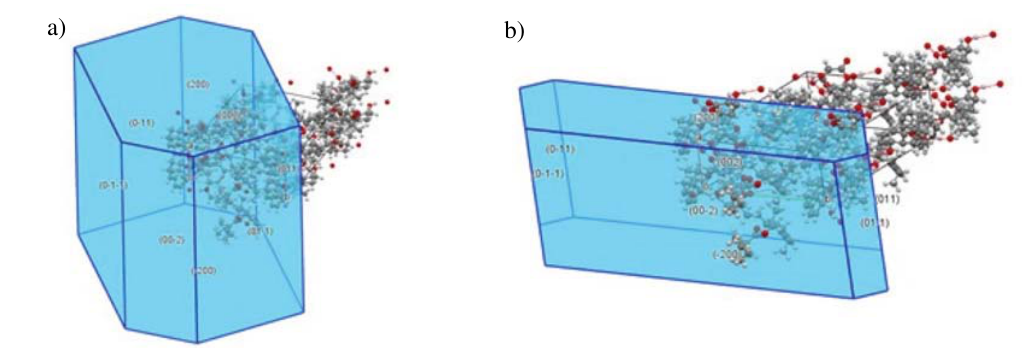
Figure 4: Packing arrangement of simvastatin in connection to the crystal habit (a) isolated from a hydrophilic solvent mixture and (b) isolated from a hydrophobic solvent mixture